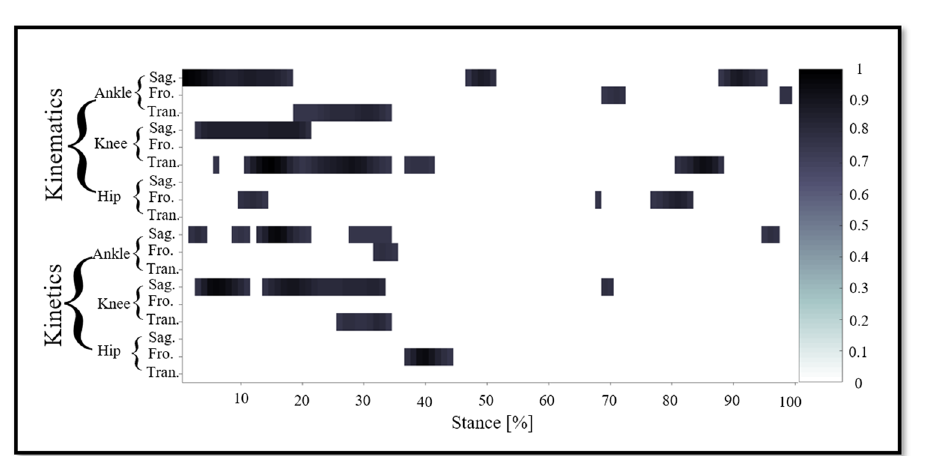
Figure 3. Notable highly relevant variable during each joint (ankle, knee, hip) of each plane (sagittal, frontal, transverse) of kinematics (joint angle) and kinetics (joint moment). The top 200 variables with the highest correlation relevance, all of them had a relevance score of over